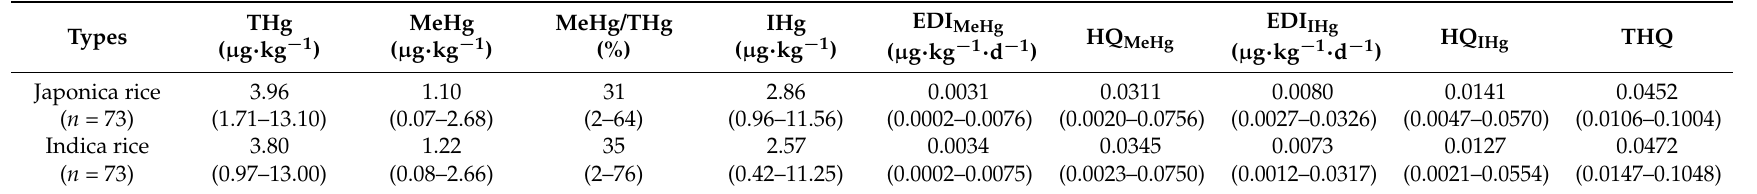
Table 1. The mean values of THg, MeHg, MeHg/THg, IHg, EDI and HQ of MeHg and IHg, and THQ in Japonica and Indica